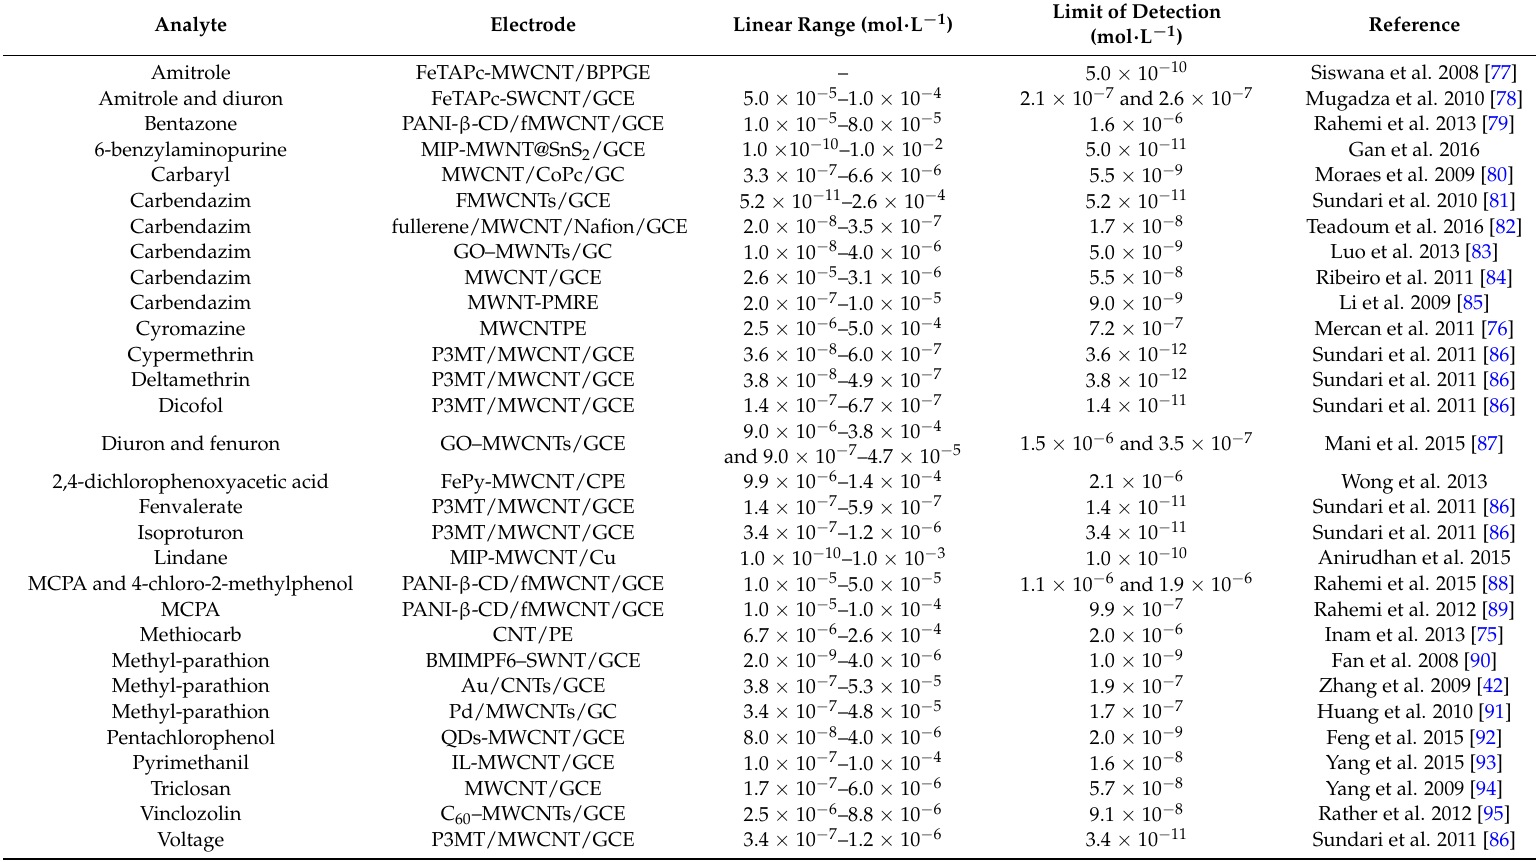
Table 1. Electrochemical sensors based on carbon nanotubes for the detection of